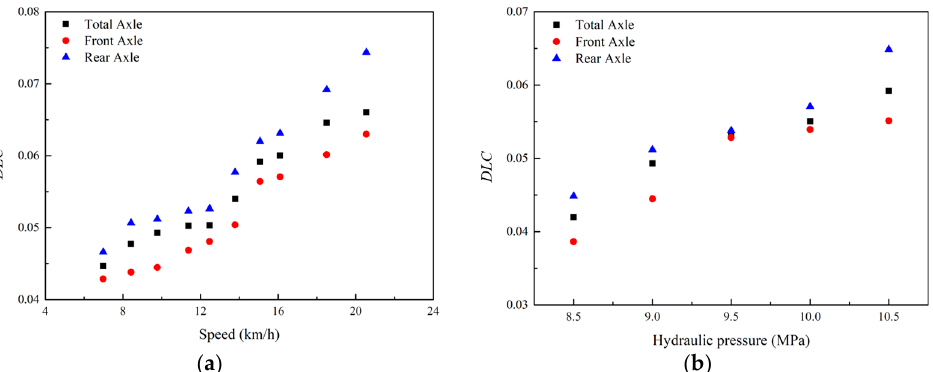
Figure 9. Measurement of dynamic axle load. ( a ) Relationship between DLC and speed. ( b ) Relationship between DLC and hydraulic pressure.